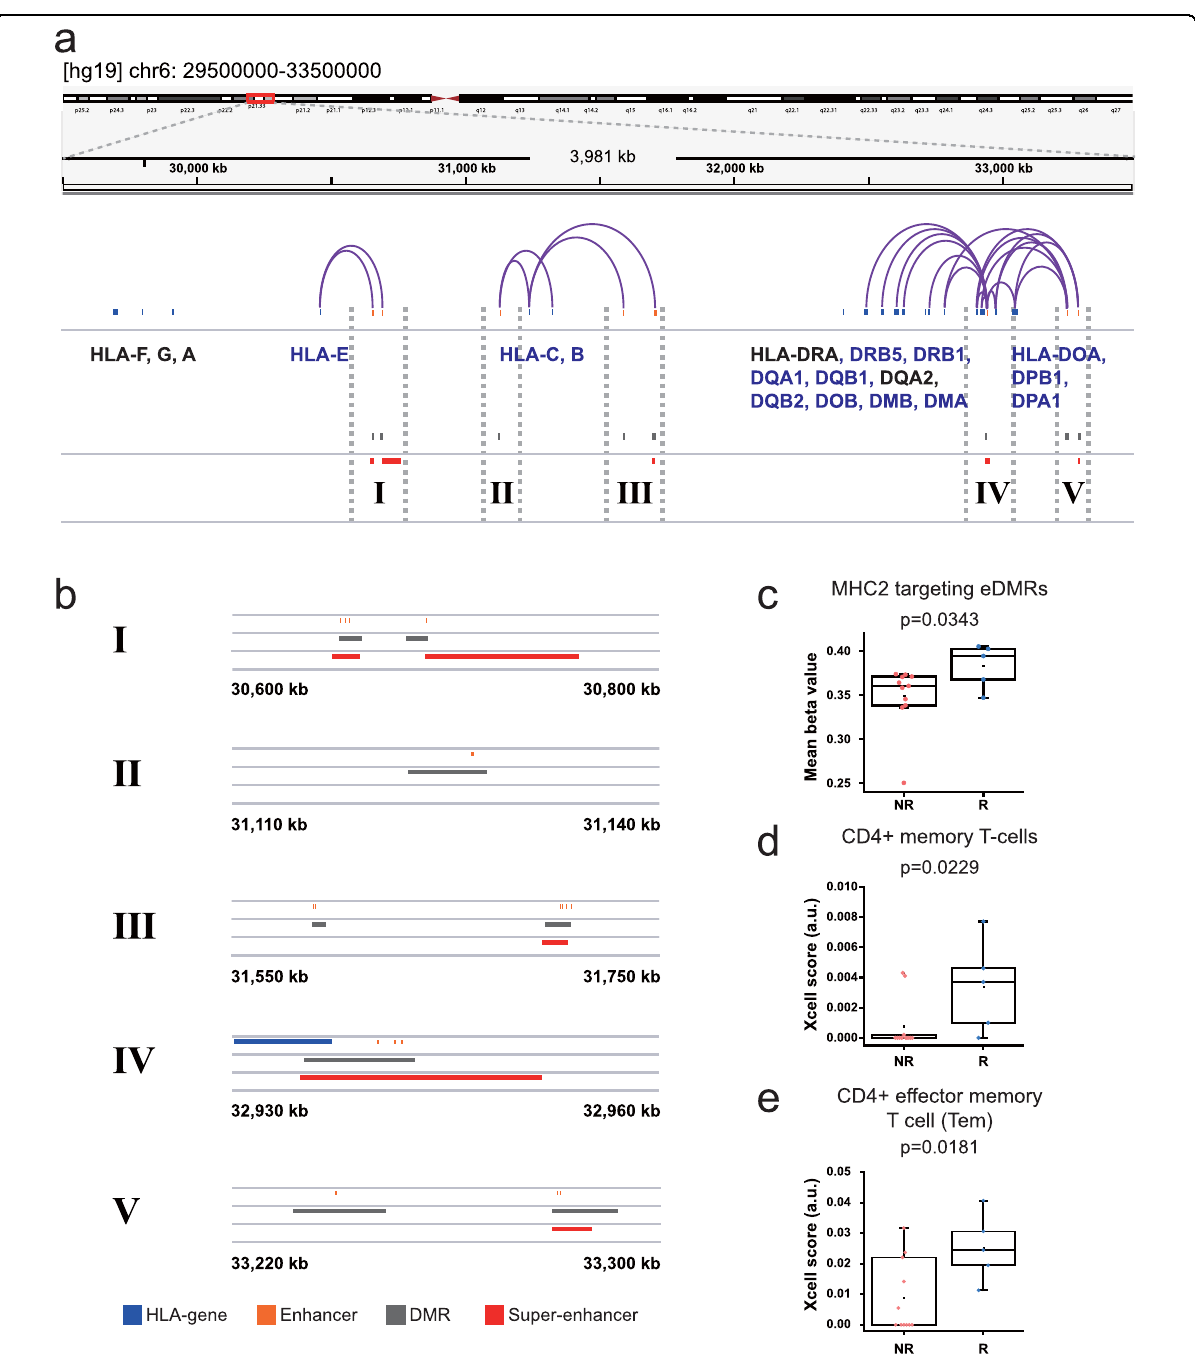
Fig. 3 Differential methylation of HLA gene enhancers for the anti-PD-1 response. a Integrative genomic view showing HLA gene clusters of human chromosome 6. Arches represent enhancer – promoter interactions. b Megascopic views of enhancer-containing regions (I – V) to highlight sequence region overlap among HLA genes, DMRs, enhancers, and super-enhancers. c Comparison of mean beta values of eDMRs targeting MHC-II between responders (R) and non-responders (NR). d , e Comparison of xCell scores between responders (R) and non-responders (NR) for CD4 + effector memory T cells d and CD8 + T cells. e The signi fi cance of difference between two groups was tested by a Wilcoxon one-sided rank sum